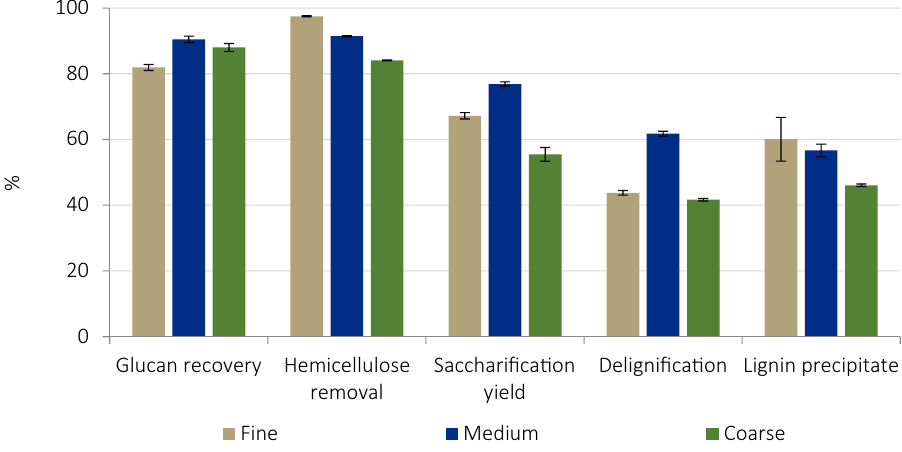
Figure 5. Effect of particle size of Miscanthus on key indicators for ionoSolv pretreatment, after pretreatment with [TEA][HSO 4 ] at 120 °C for 6 h at bench scale using a biomass loading of 20